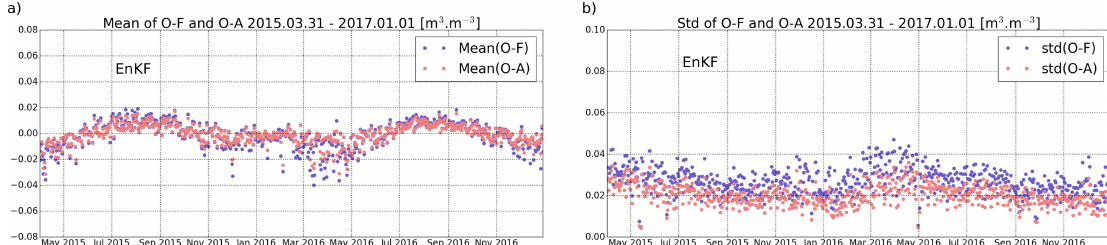
Figure 2. ( a ) domain average Observation-minus-Forecast (O-F) soil moisture (m 3 m − 3 ) (blue) and Observation-minus-Analysis soil moisture (m 3 m − 3 ) (red) residual for the EnKF; ( b ) domain standard deviation of O-F (m 3 m − 3 ) (blue) and O-A soil moisture (m 3 m − 3 ) (red) for the EnKF.